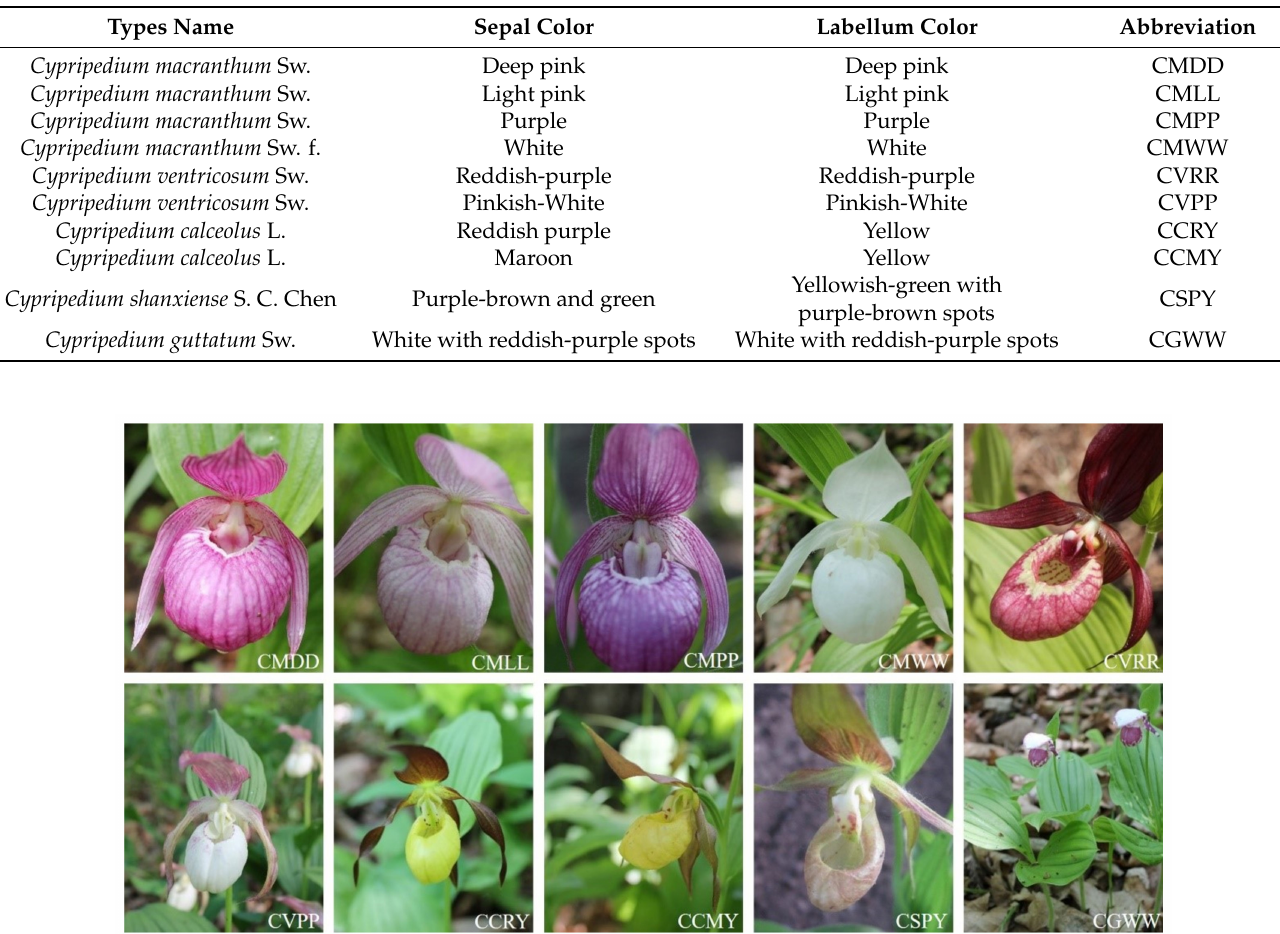
Table 1. 10 tested Cypripedium samples were given test numbers, types name, sepal color, and